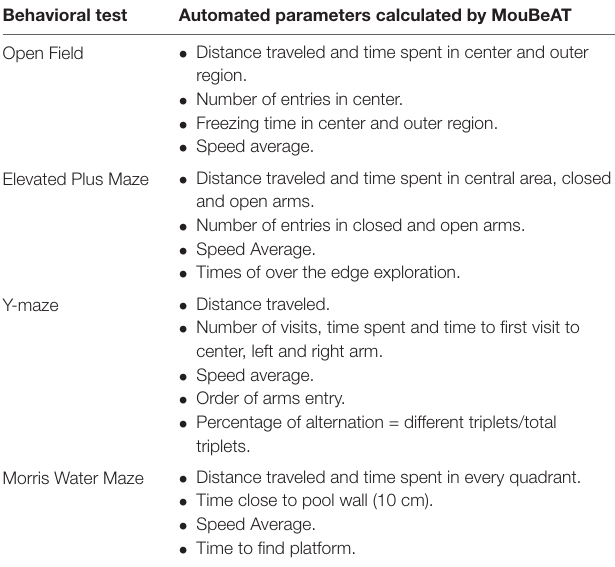
TABLE 1 | Automated parameters measured by Mouse Behavioral Analysis Toolbox (MouBeAT) in five behavioral